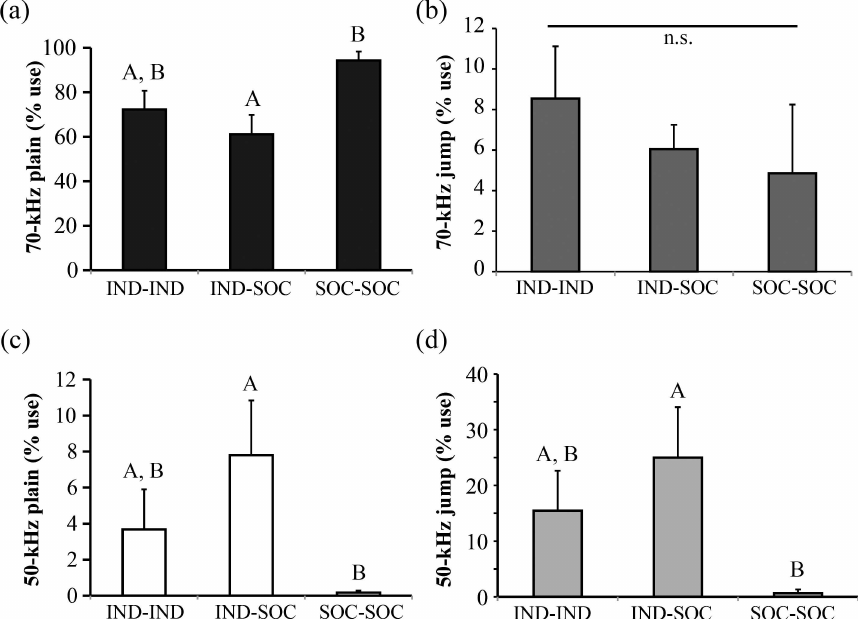
Fig 3. Social history influences the proportional use of different ultrasonic vocalization (USV) types emitted by pairs of male mice. (a) Proportional use of 70-kHz plain USVs. (b) Proportional use of 70-kHz jump USVs. (c) Proportionaluse of 50-kHz plain USVs. (d) Proportional use of 50-kHz jump USVs. Bar heightsrepresent means ± S.E.M; bars with different letters are statisticallydifferent (Kruskal-Wallis tests with Bonferroni post-hoc tests, p < 0.05). IND = individuallyhousedmale; SOC = sociallyhousedmale. See methods for additional details regardinghousinghistory and USV